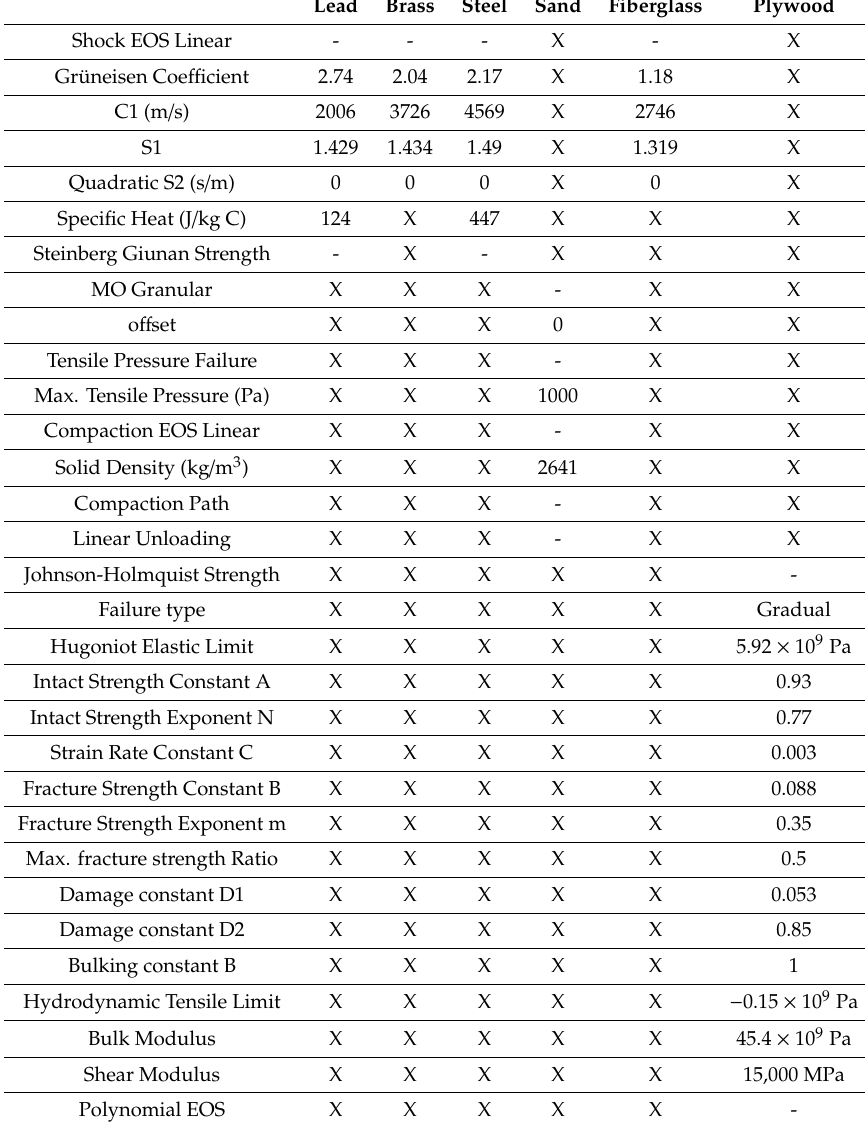
Table 4. Configuration parameters for the